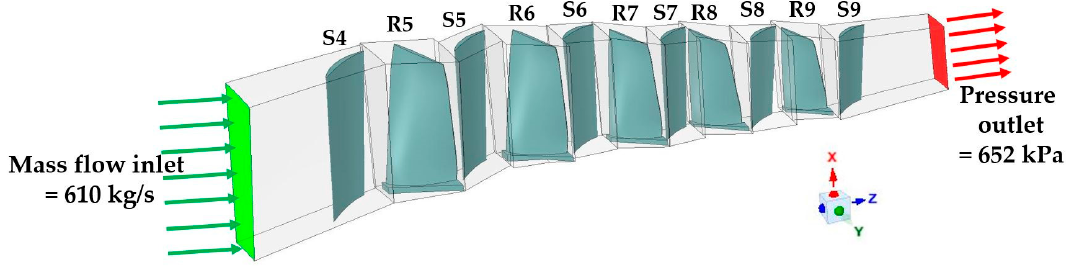
Figure 5. Final fluid domain and the boundary conditions.